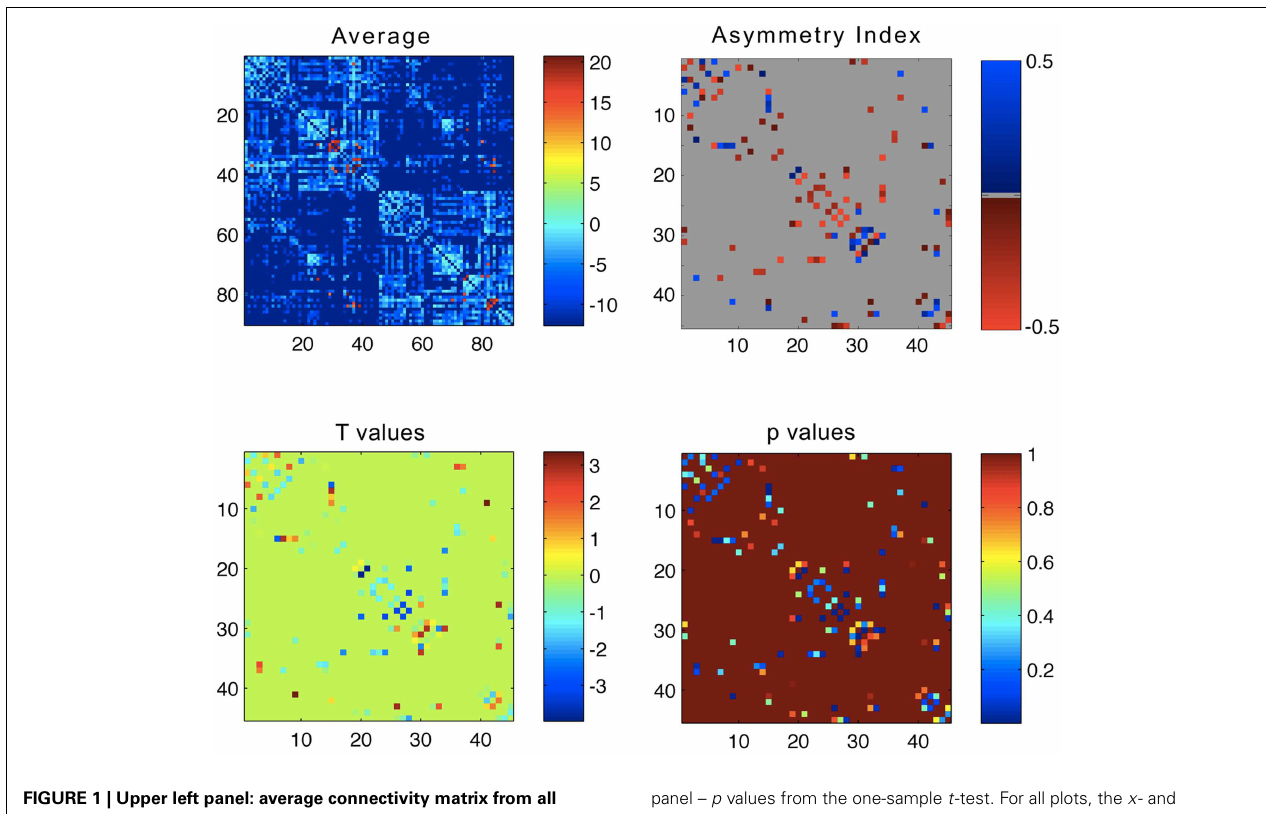
FIGURE 1 | Upper left panel: average connectivity matrix from all subjects – the scale bar represents log(connectivity weight) . Upper right panel – link-wise average asymmetry index. Lower left panel – T values from a one-sample t -test evaluating the differences between the asymmetry indices and a distribution with mean = 0. Lower right